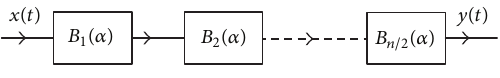
Figure 1: Oscillators of 2-order in